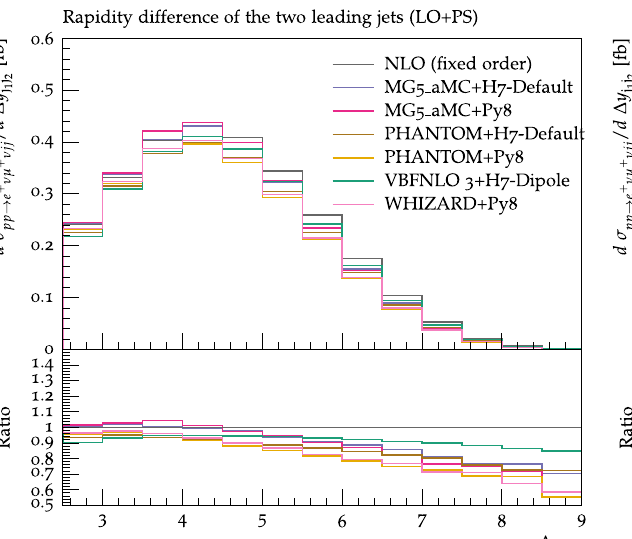
shown, while for MG5_aMC + Pythia8 the darker and lighter bands correspond respectively to the nine-point scale uncertainty and the scale and PDF uncertainties combined linearly. The predictions are obtained in the fiducial region described in Sect. 3.3